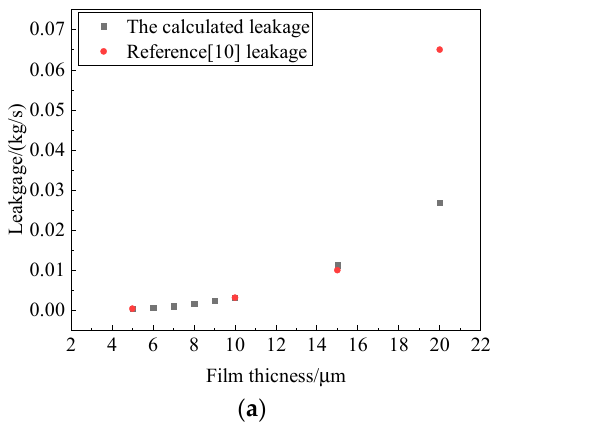
Figure 2. The verification of calculated results. ( a ) Calculated leakage with Ref. [10]; ( b ) The pressure distribution with different Λ